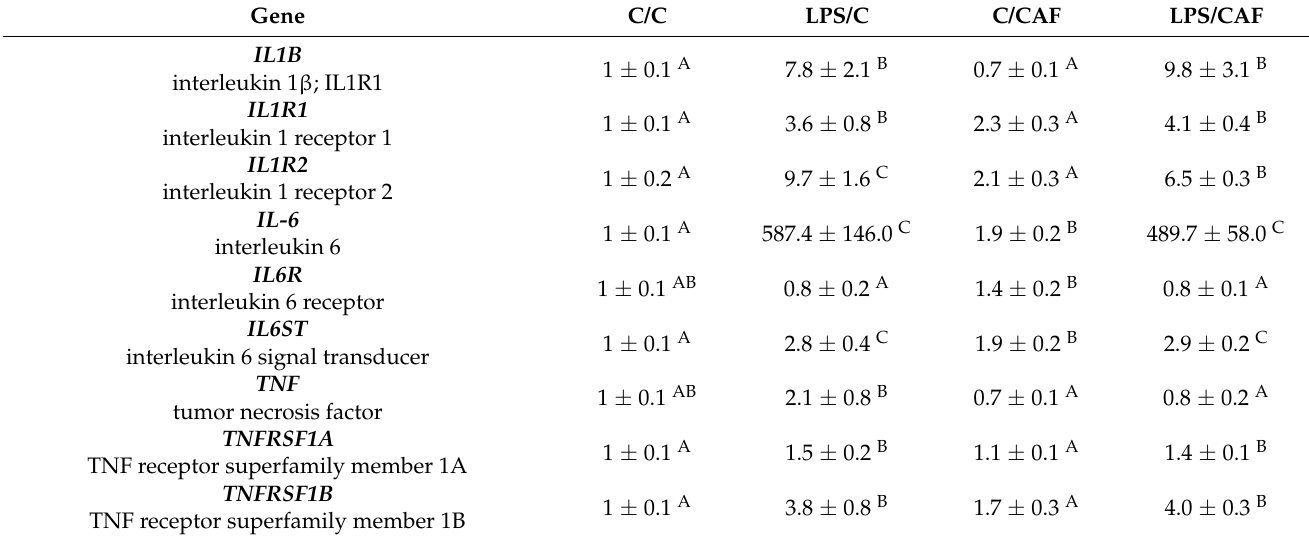
Table 2. The effect of caffeine on the relative gene expression (mean ± SEM; n = 6) of pro-inflammatory cytokines and their receptors in the ovine choroid plexus in basal and lipopolysaccharide-challenge